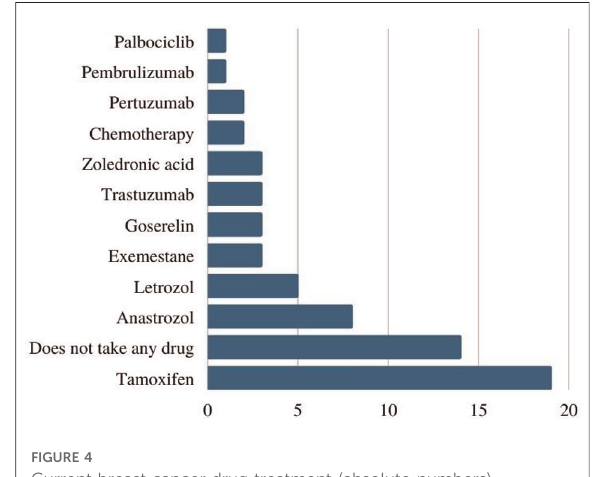
FIGURE 4 Current breast cancer drug treatment (absolute